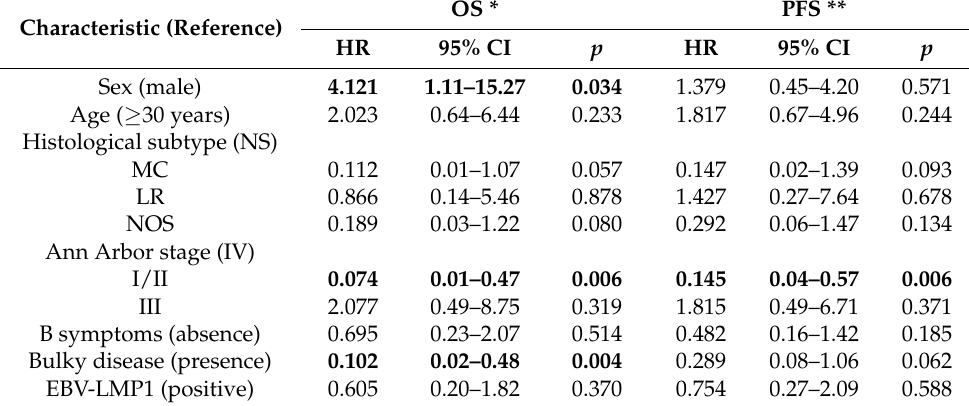
Table 5. Multivariate Cox regression analysis for overall survival and progression-free